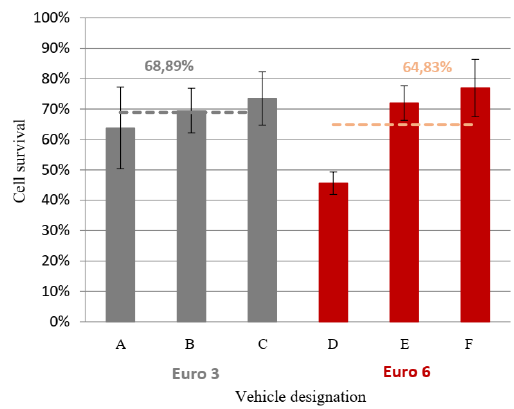
Fig. 13. Mean cell survival calculated with using a hemocytometer [19] For the tested vehicles complying with the Euro 3 standard, the cell survival was found to be approximately 4% higher in comparison with the vehicles complying with the Euro 6 standard, which means higher toxicity of exhaust gases for the tested vehicles of newer generation